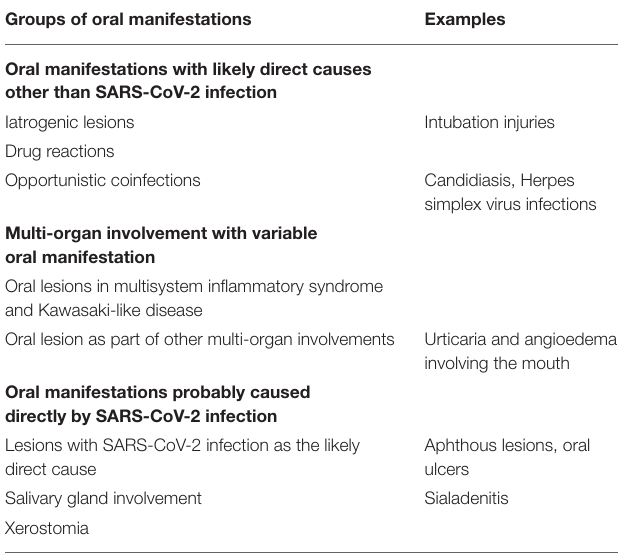
TABLE 2 | Classification of oral manifestations (except taste alterations) in patients with COVID-19 according to etiology. Groups of oral